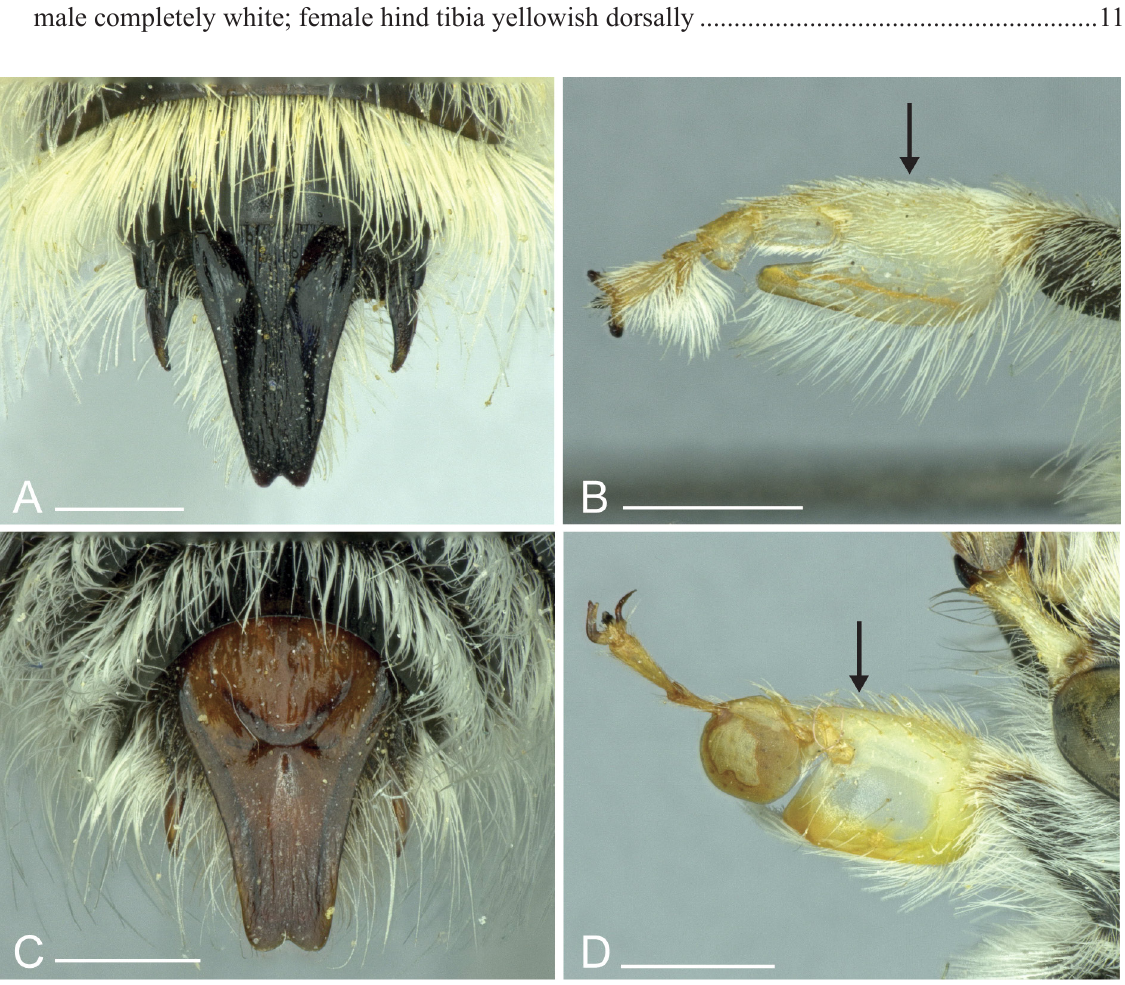
Fig. 7. Fidelia spp., ♂♂. A – B . Fidelia ornata (Cockerell, 1932). A . T7. B . Forebasitarsus. C – D . F. major Friese, 1911. C . T7. D . Forebasitarsus. Scale bars: 1